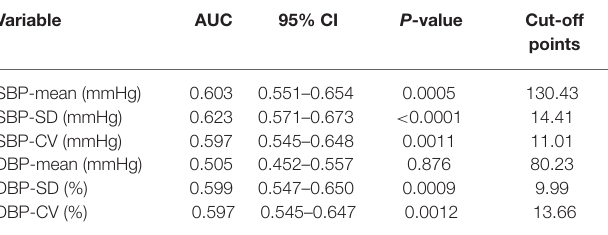
TABLE 8 | Comparison of each blood pressure parameter combined with conventional risk factors in differentiating unfavorable outcome at 3 months. Variable AUC 95% CI Change in